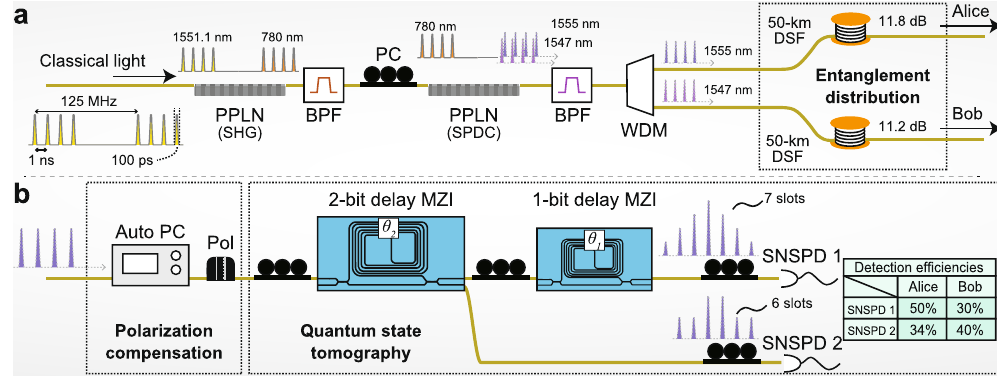
Figure 1. Experimental setup. ( a ) Generation and distribution of four-dimensional time-bin entanglement. ( b ) Alice and Bob’s measurements. PPLN, periodically poled lithium niobate waveguide; BPF, band pass filter; PC, polarization controller; WDM, wavelength demultiplexing filter; DSF, dispersion shifted fibre spool; Auto PC, remote controllable polarization controller; Pol, polariser; MZI, Mach-Zehnder interferometers; SNSPD, superconducting nanowire single photon detector. The inset shows the detection efficiencies of the